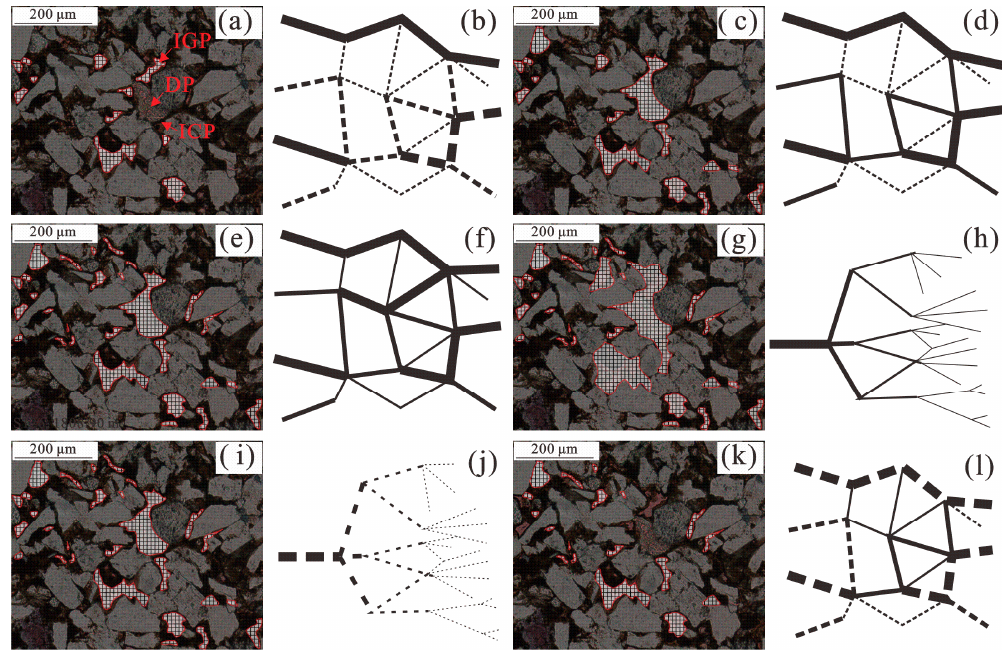
Figure 4. TS observations (net region with red rim represent the area that mercury occupies at this